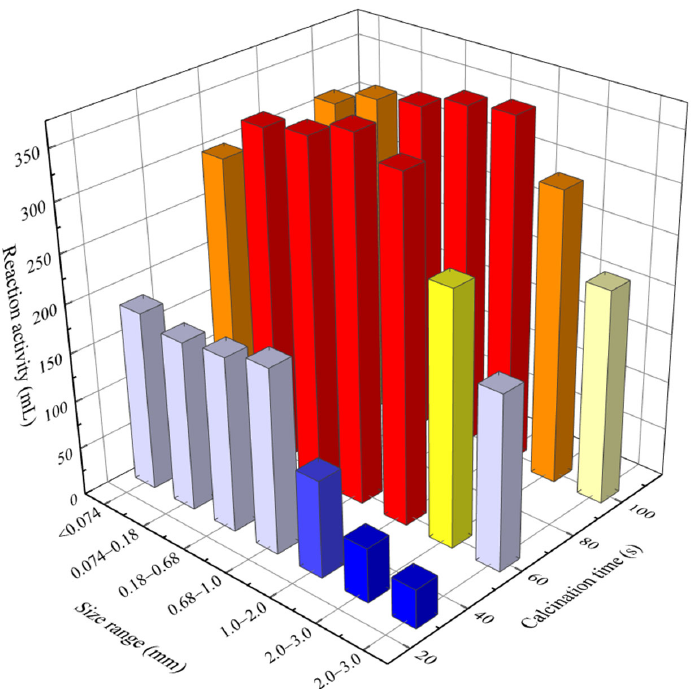
Figure 9. The activity of lime with different particle sizes calcined at different times.